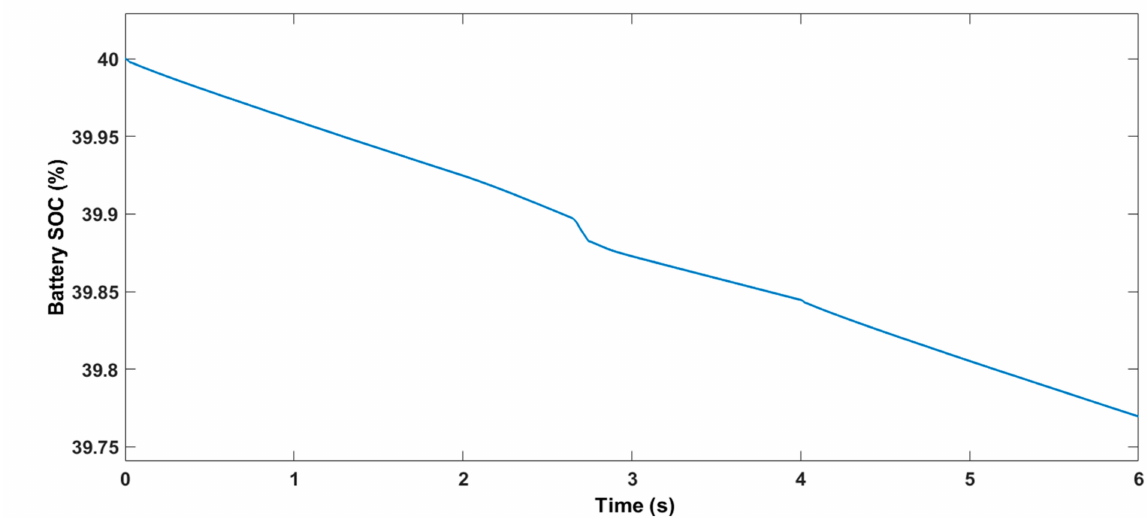
Figure 26. Battery’s SOC at 40% during variable speed.